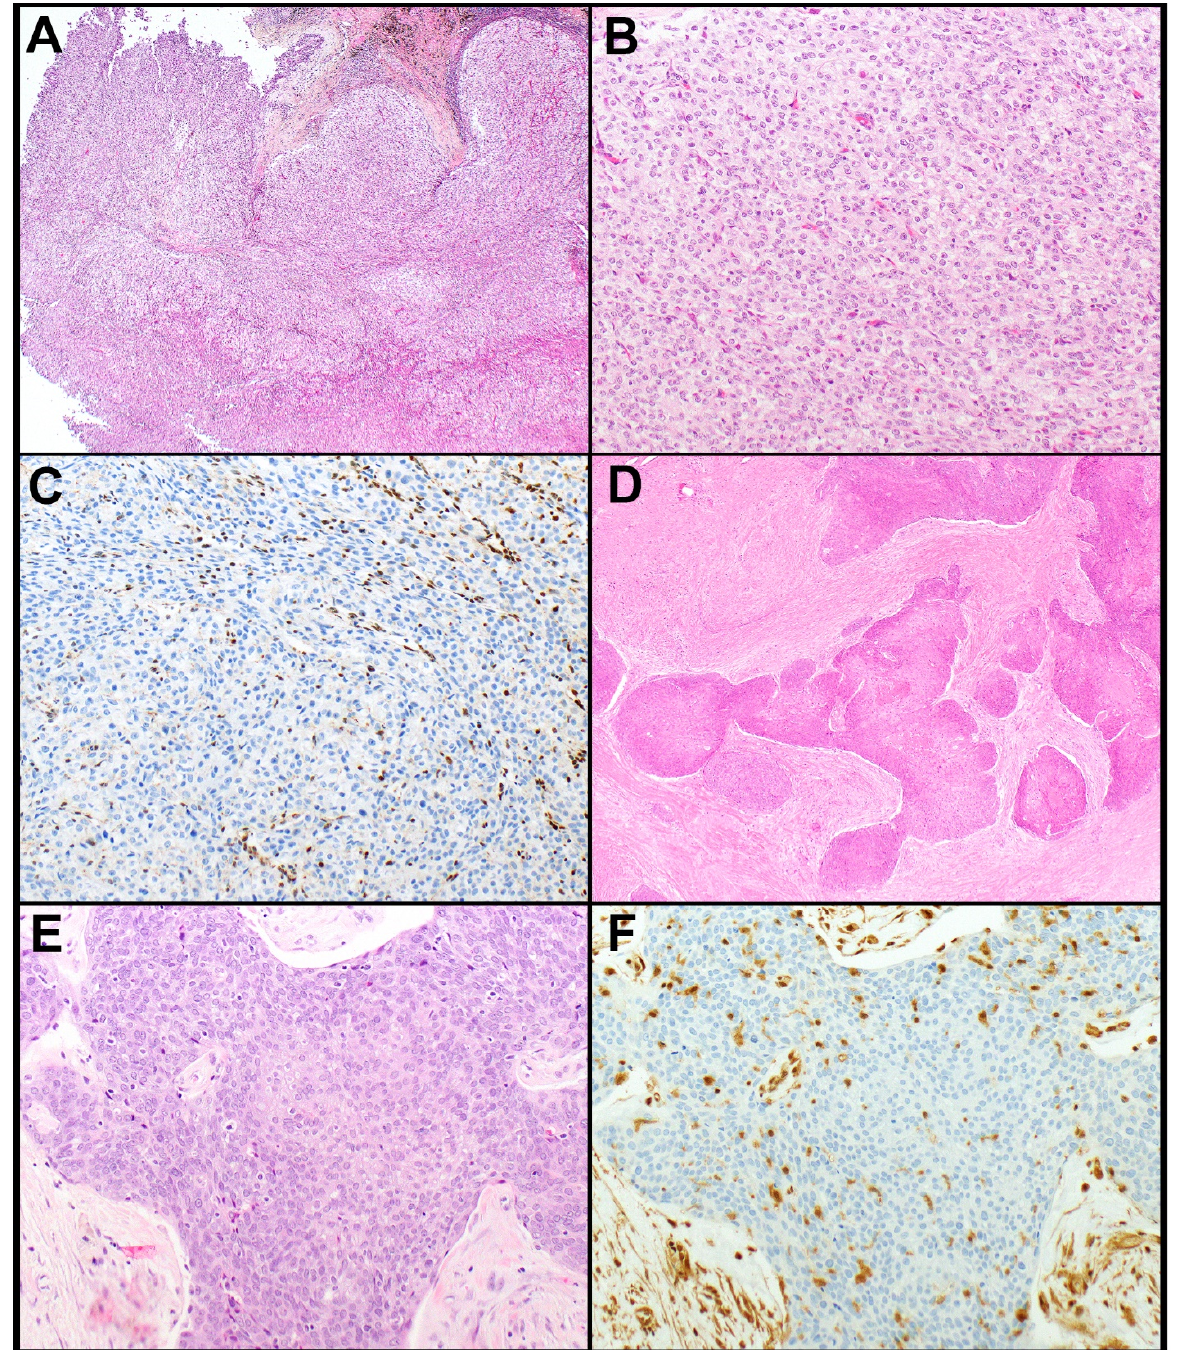
Figure 1. (A – C ). Thymic adenocarcinoma. ( A ) The tumor grows in a solid pattern and is comprised of polygonal tumor cells with ample cytoplasm and round nuclei ( B ). ( C ) BAP1 expression is lost in the tumor cells. Note expression of BAP1 is preserved in endothelial cells. ( D – F ). Thymic squamous cell carcinoma. ( D ) Large irregular nests of tumor cells are in a desmoplastic and fibrotic stroma. ( E ) The tumor cells are polygonal and have, at least in some areas, a fair amount of cytoplasm. ( F ) mTAP expression is lost in the tumor cells. Note the preserved expression of mTAP in endothelial and stromal cells. Magnification, H&E × 40 ( A , D ), × 200 ( B , E ), BAP1 × 200 ( C ), mTAP × 200 ( F ).